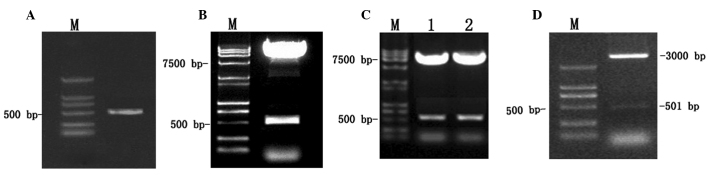
Construction and identification of plasmids by agarose gel electrophoresis. (A) Polymerase chain reaction product MHBst167 (501 bp). (B) Restriction enzyme digestion of pGBKT7-MHBst167 plasmids by EcoRI/BamHI (pGBKT7, 7,300 bp; MHBst167, 501 bp). (C) Restriction enzyme digestion of (Lane 1) pGBKT7-MHBst167 and (Lane 2) pGADT7-MHBst167 by EcoRI/BamHI. (D) Restriction enzyme digestion of pGEM-T-MHBst167 plasmids by EcoRI/BamHI. M, DL2000 DNA marker; bp, base pairs.